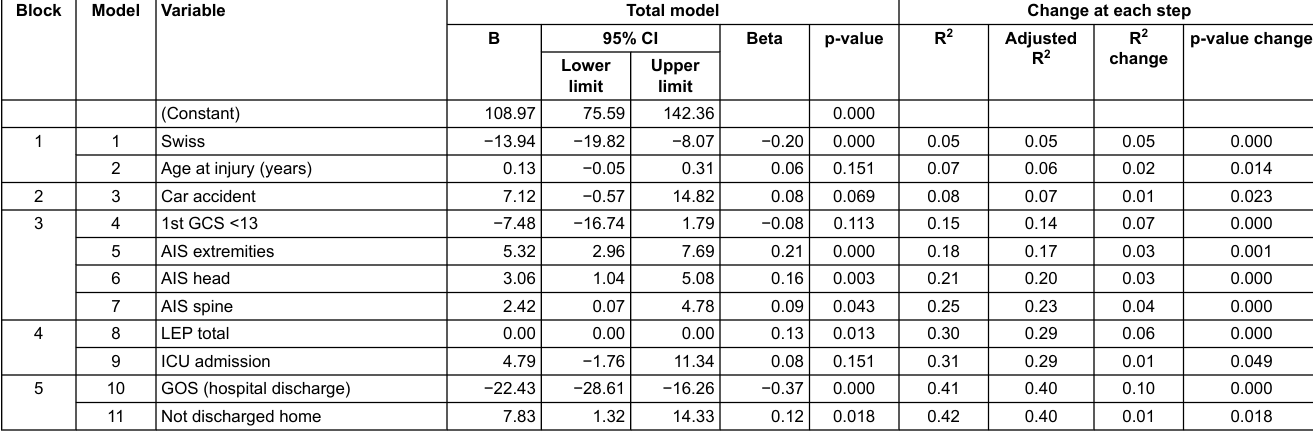
Table 2: Multivariate analysis of demographic, injury, and early hospital characteristics of survivors of trauma explaining the mean PRCW 1–4 years after injury. Block Model Variable